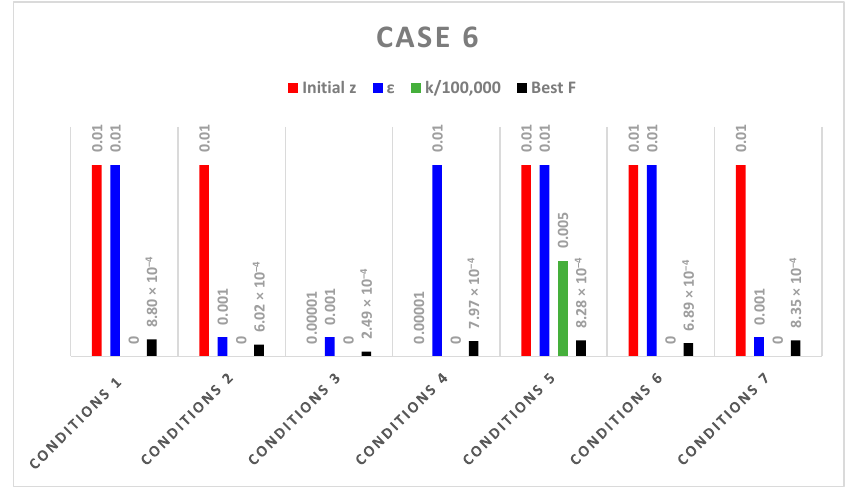
Figure 10. Graphical presentation of Table 9.